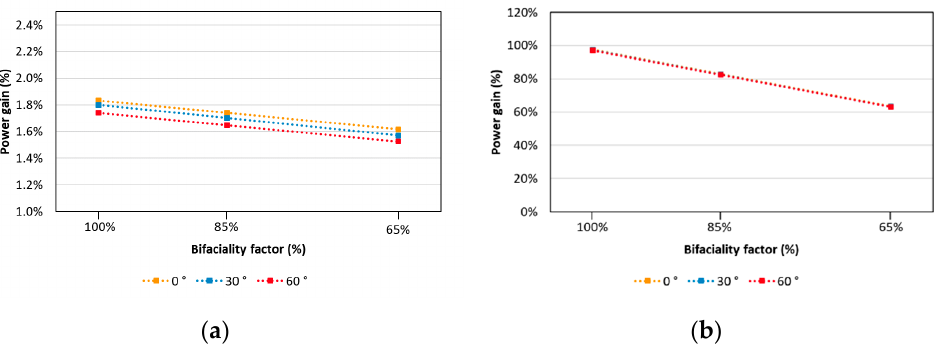
Figure 10. Power gain depending on bifaciality factor: ( a ) power gain due to internal reflection; ( b ) power gain due to rear side irradiance.